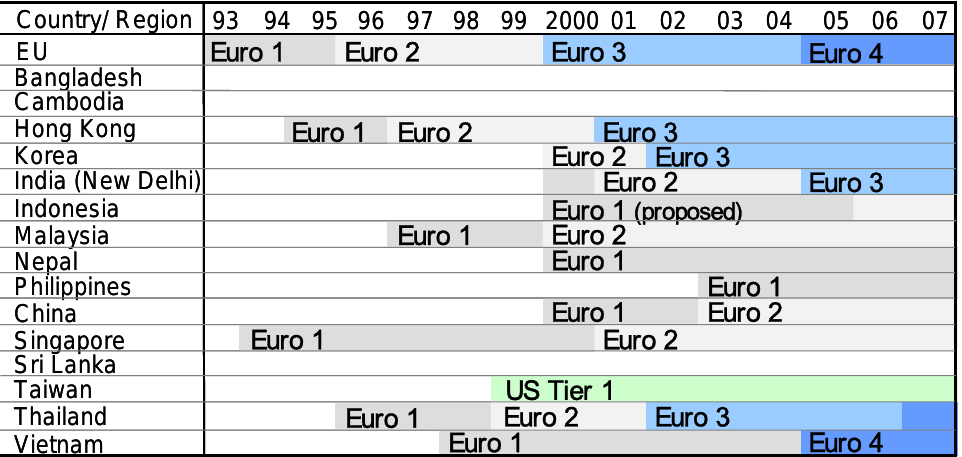
Table 3. Timetable for introduction of new emission control standards in Asia